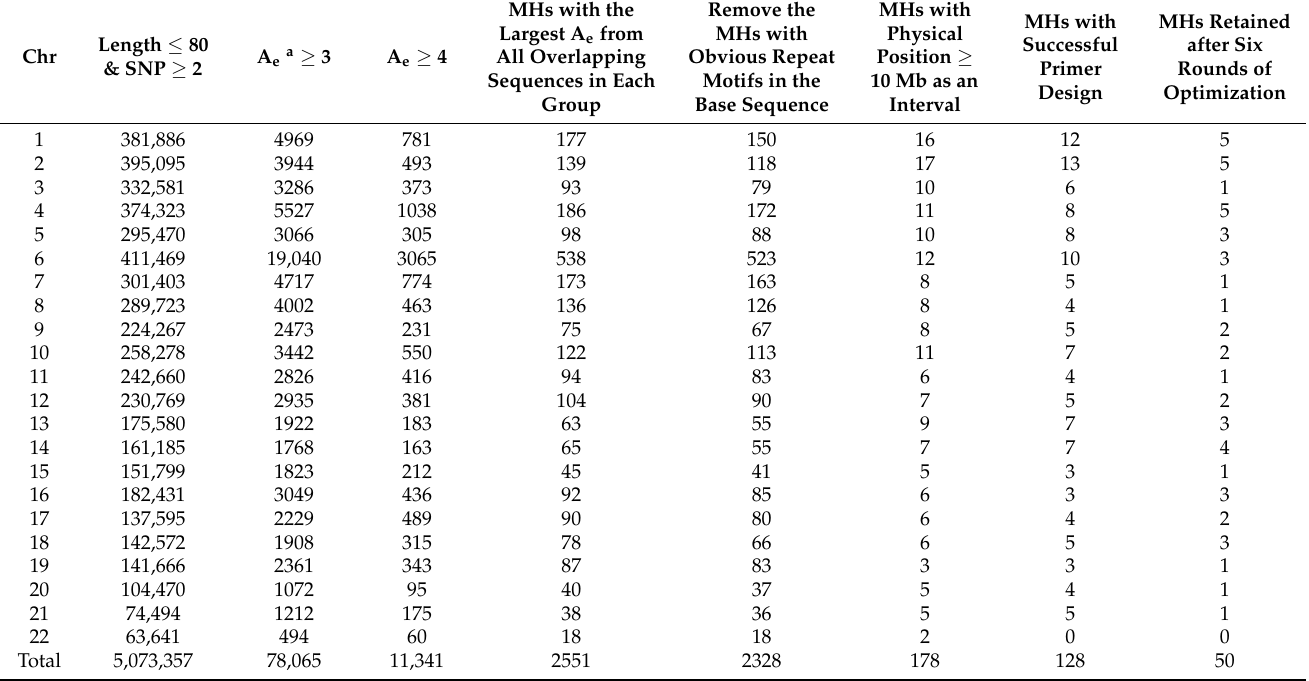
Table 1. Numbers of loci during the stepwise construction of the microhaplotypes (MHs) panel.